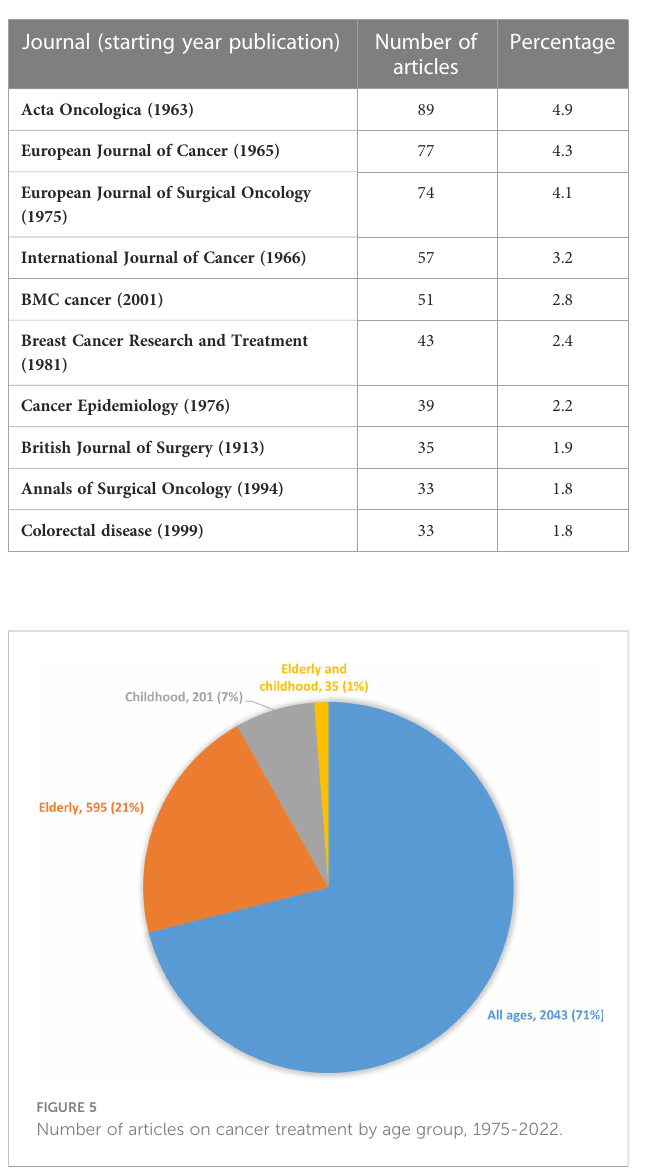
TABLE 2 Number of articles on cancer treatment published in the 10 most frequent Journals, 2013-2022.